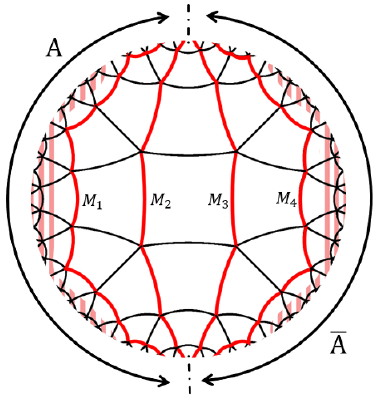
Figure 26 . (cid:9) c is sliced into periodic tensor chains f M 1 ; M 2 ; M 3 ; M 4 g (red polylines) in tensor network with f 4 ; 5 g tiling and S c =